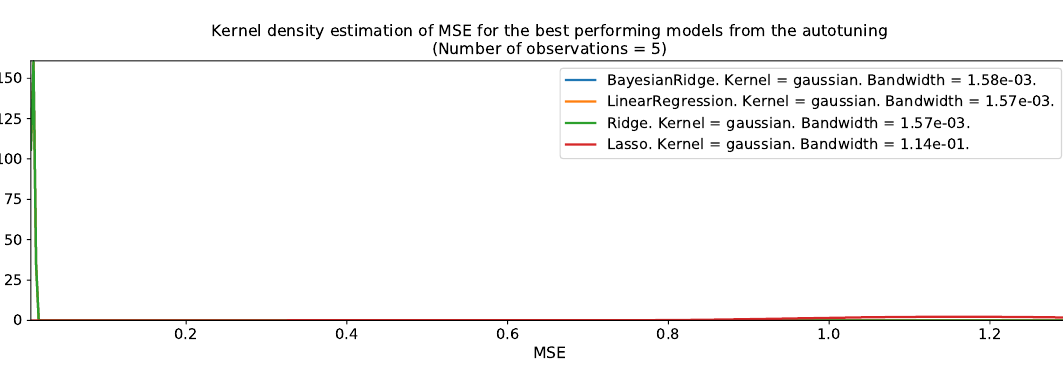
Figure 21. Estimated probability density functions of the mean square error in the spatiotemporal regression of the population distribution for different families of models as returned by the autotuning program in Valledupar. Rionegro Kernel density estimation of MSE for the best performing models from the autotuning (Number of observations = 5) BayesianRidge. Kernel = gaussian. Bandwidth = 4.31e-04. LinearRegression. Kernel = gaussian. Bandwidth = 4.31e-04.